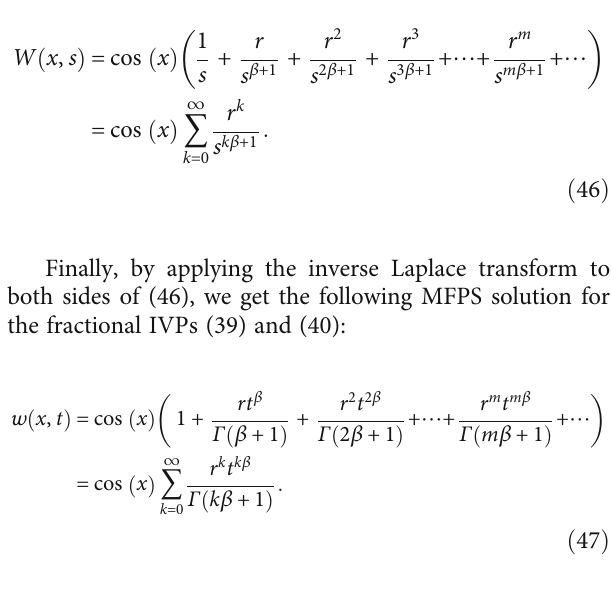
x , t Þ at various β values and t = 0 : 125 , for Example 3. 5 ð